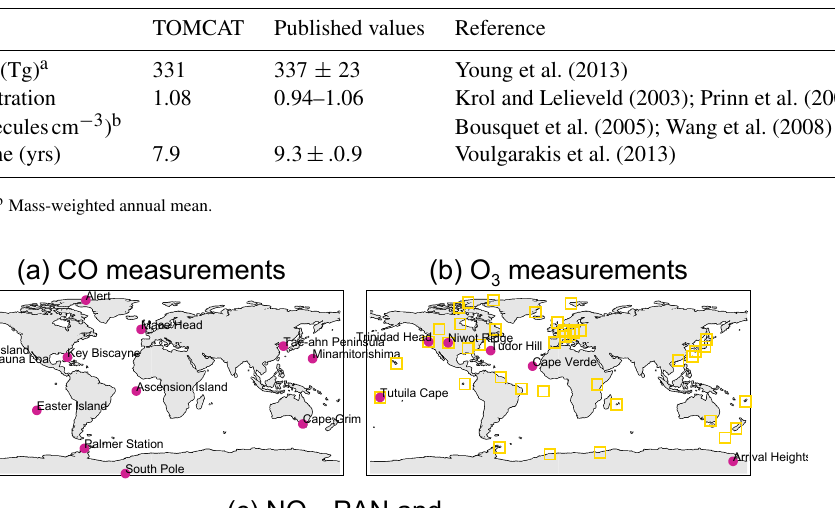
Table 7. Model diagnostics compared to previously published values.